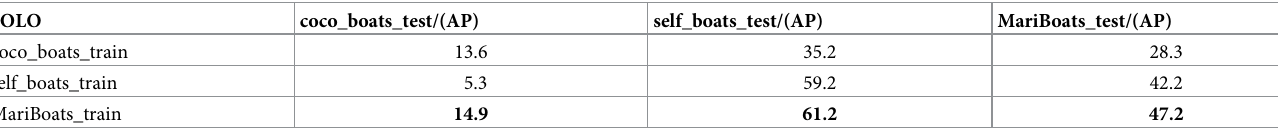
Table 3. Test results of SOLO in the three instance segmentation